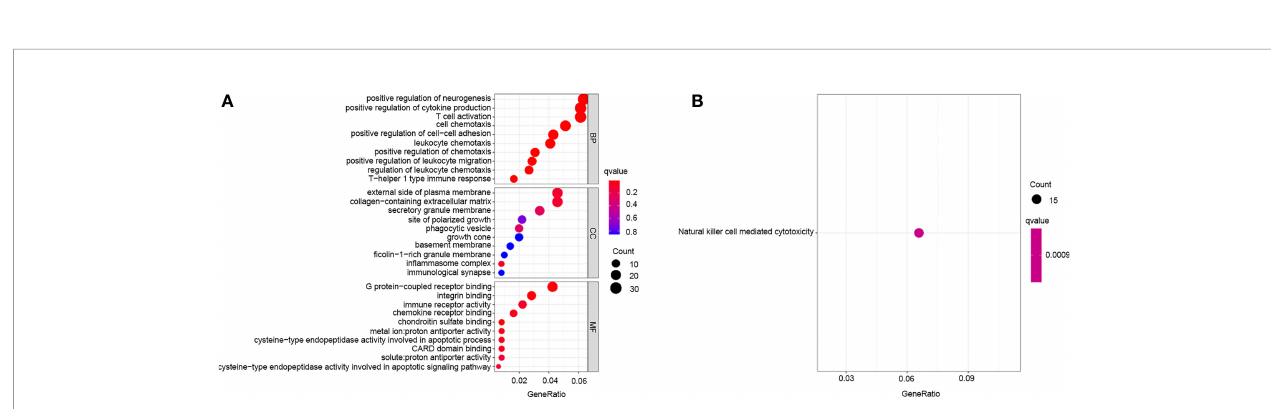
FIGURE 4 | Transcriptome characteristics of m6A modi fi cation patterns in cervical cancer. (A) GO enrichment analysis of m6A differentially expressed genes. (B) KEGG pathways of m6A differentially expressed genes.